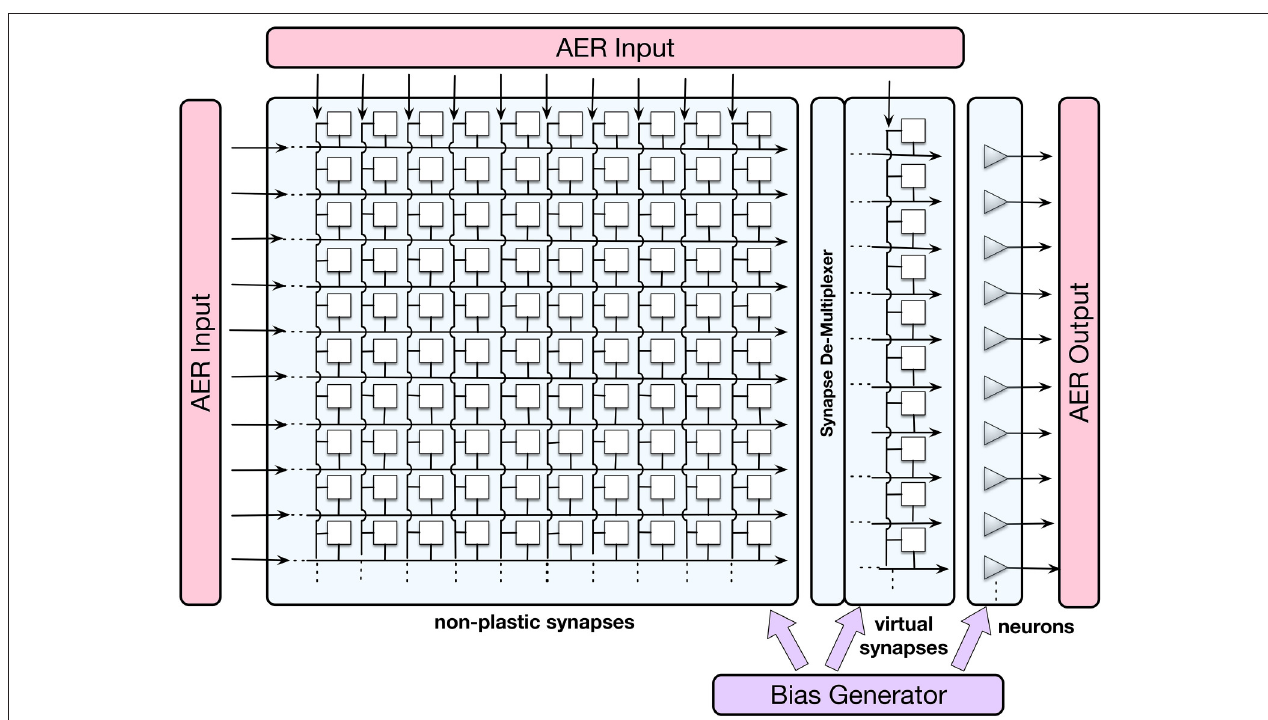
FIGURE 2 | The schematic visualization of neurons (grey triangles), non-plastic and virtual synapses (white squares), as well as input-output interfaces and bias generator of the ROLLS chip. Each neuron on the chip (presynaptic neuron) sends its output spikes to 256 non-plastic synapses, which, if set active, can route these spikes to any of the neurons on the chip (postsynaptic neurons). The connectivity matrix allows for all-to-all connectivity, but also other configurations. AER is a digital Address-Event Representation, used to communicate spikes (it consists of an index of the spike-emitting neuron).